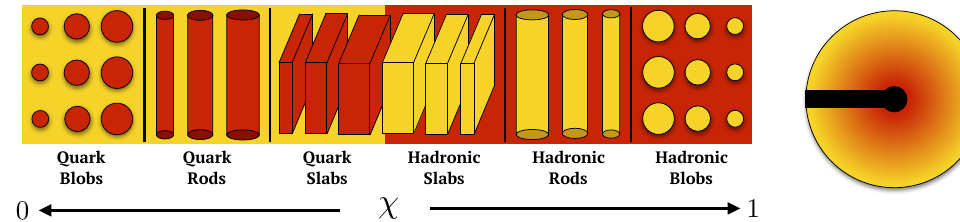
Figure 1. Schematic illustrating the rare phase structures that may form in the quark–hadron mixed phase [6,7]). An increase in the volume fraction of quark matter, described by χ , is accompanied by an increase in baryon number density and depth within a neutron